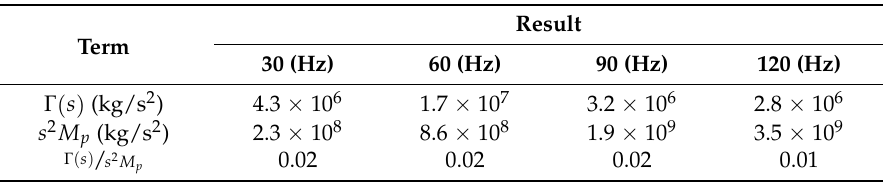
Table 4. Theoretical calculation result regarding response index.